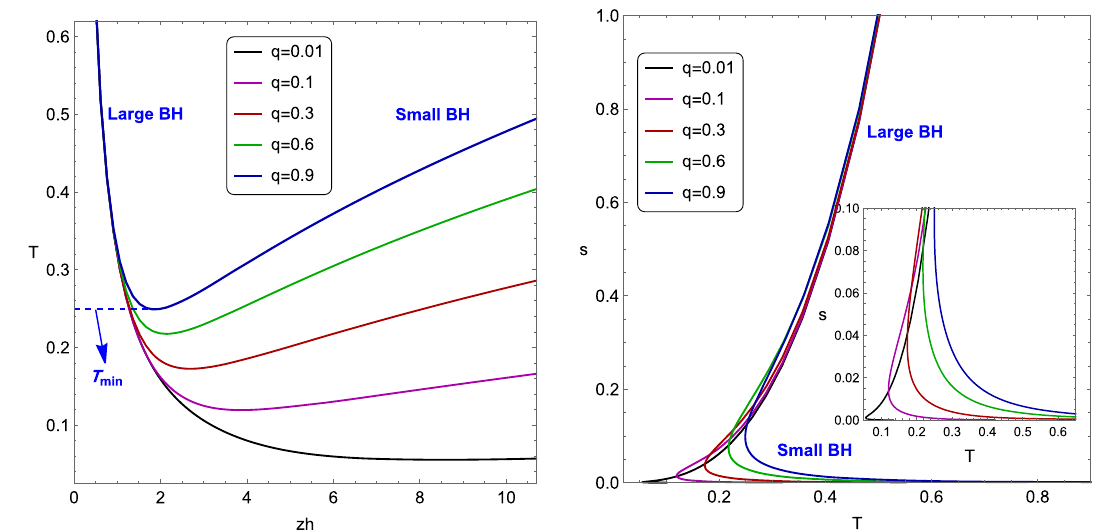
Fig. 1 Left: Temperature of the black hole T as a function of the hori- zon z h for different values of charges. Right: Entropy of the black hole s as a function of the temperature T for different values of charges. For